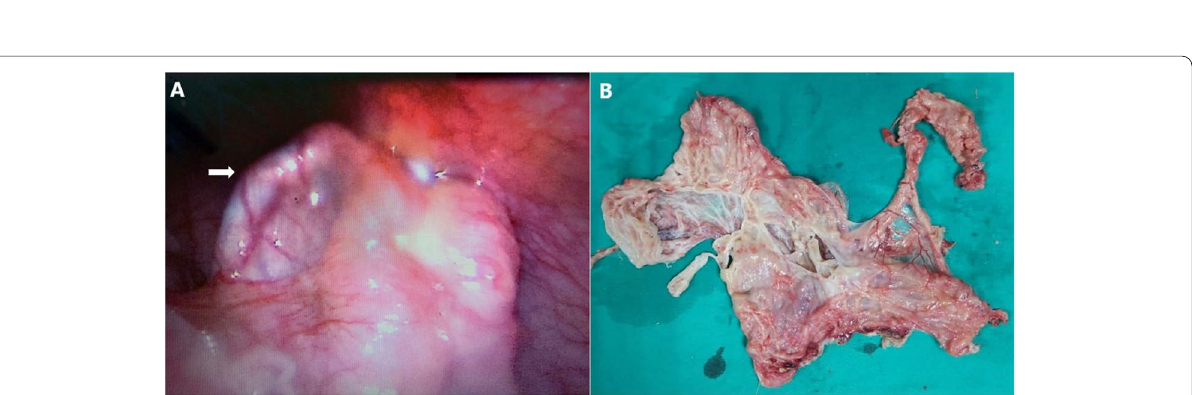
Fig. 3 A Laparoscopic image shows a huge omental cyst with pigtail drainage in situ (arrow). B Gross specimen of excised omental